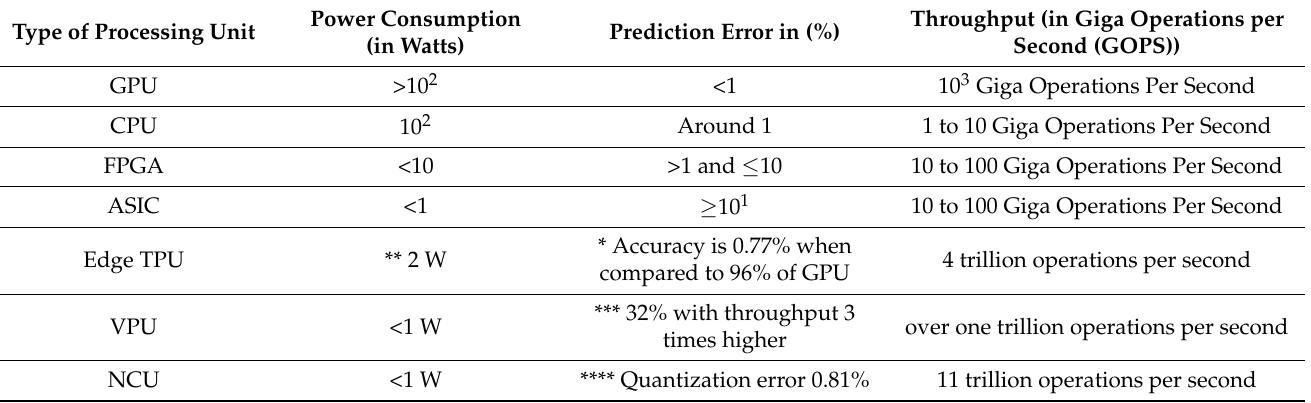
Table 3. Comparison of power consumption, prediction error, and throughput of different processing units. Type of Processing